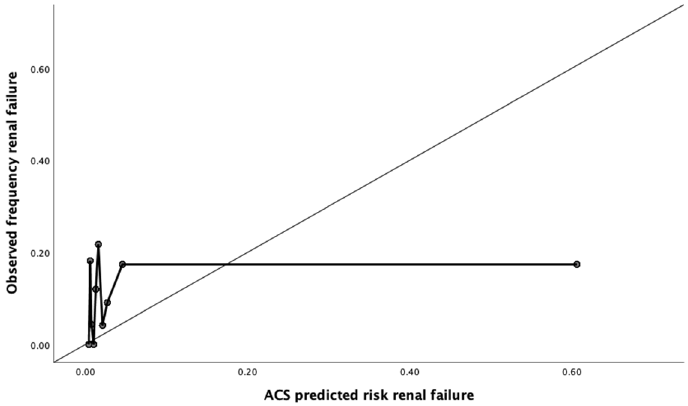
Figure 1. Calibration plots for the risk of complications.